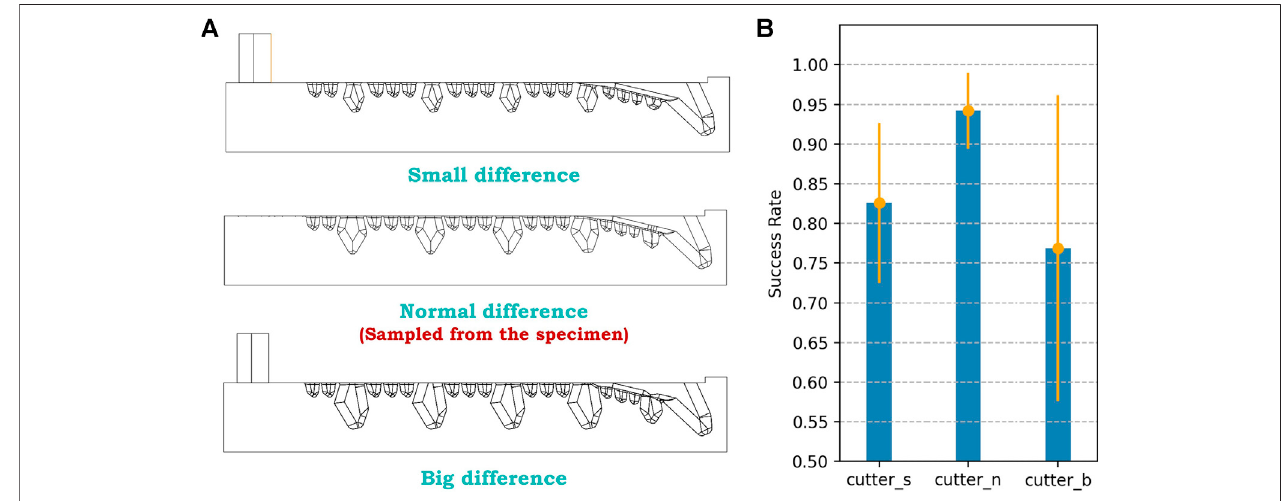
FIGURE 11 | Third iteration bionic parametric exploration designs and their performance, with mean and